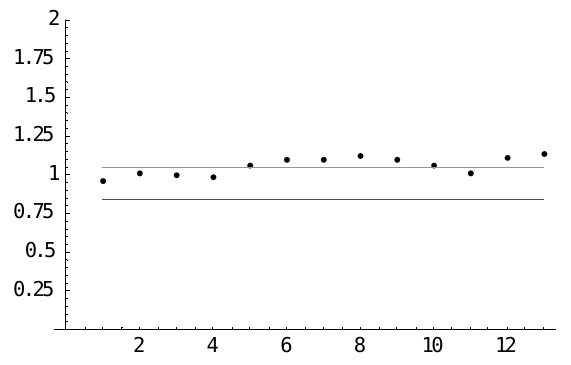
Fig. 18. Evolution of the sunspot cycles 24–56 modelled by the modified nonlinear mapping. For such long-term extrapolations, due to the sensitivity of the solution to initial conditions, only quali- tative information about the dynamlical evolution is meaningful be- yond a few solar cycles. In this respect, this extrapolated sunspot time series contains long-term modulations of the cycle amplitude, in good accordance with observations from the last two centuries. Note also that this multi-century extrapolation does not display sys- tematic secular trends or periods of Grand Minima (intermittent in- terruptions of the solar cycle, with constantly low activity, as ob- served in past centuries) in the upcoming 3